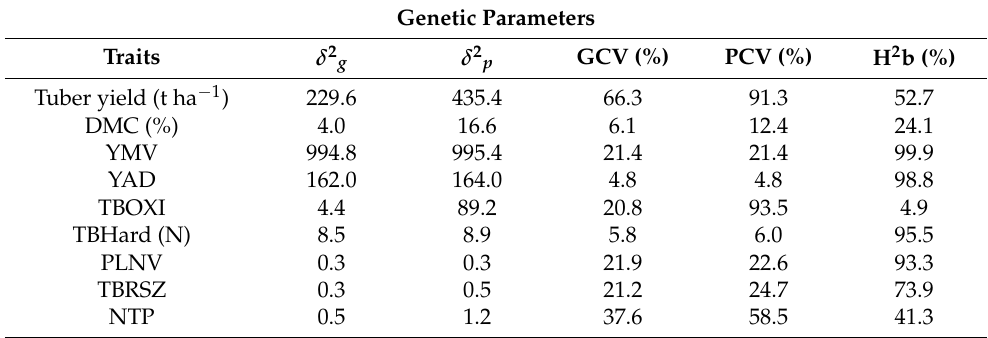
Table 3. Genetic variability and broad-sense heritability in D. praehensilis and D. rotundata accessions.